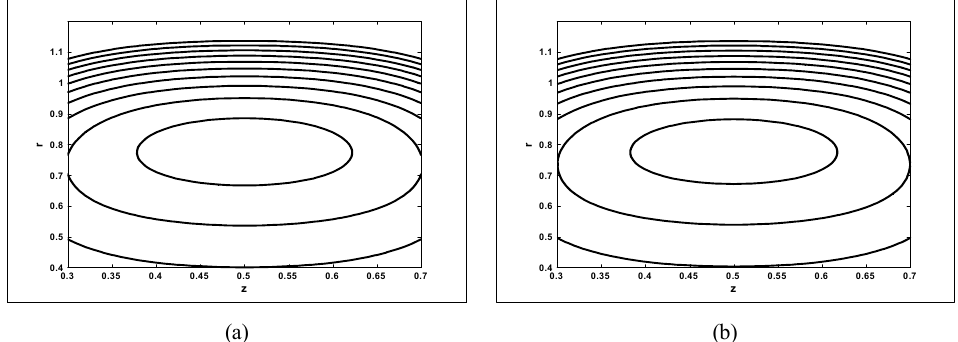
Figure 17. Streamlines for two di ff erent values of M for ( a ) M = 0.2 and ( b ) M = 0.1. The other parameters are chosen as ϕ = 0.1, Q = 0.4, r 1 = 1.1 when µ = 1